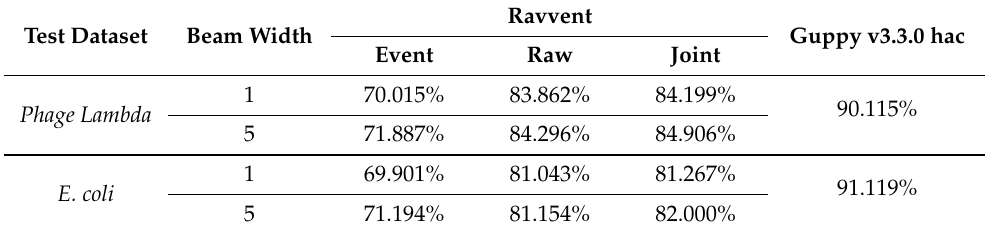
Table 2. Test accuracy of models trained on real data.